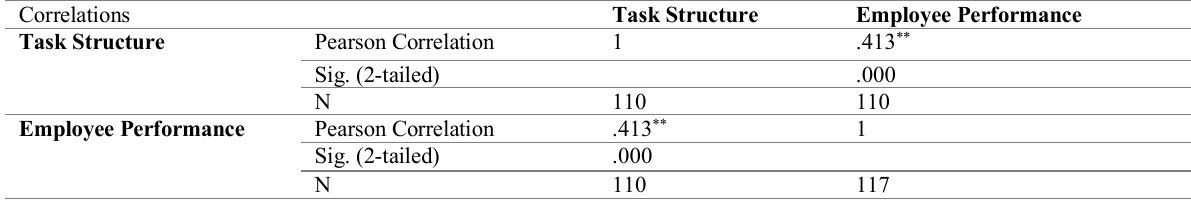
Table 12: Correlations between task structure and employee